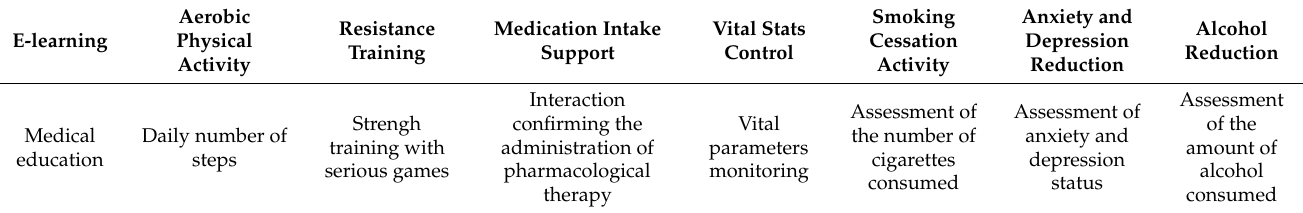
Table 6. Components of the virtual cardiac rehabilitation